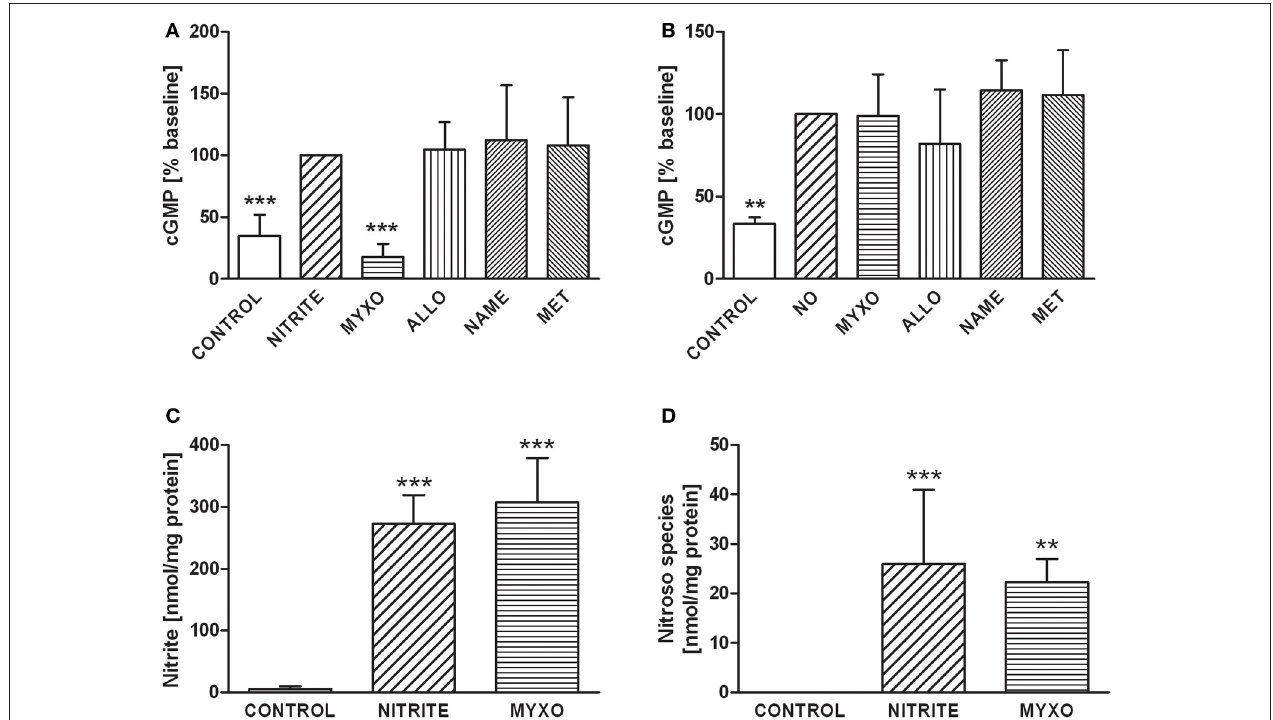
FIGURE 3 | (A) GMP levels in HL-1 incubated with 50 µ M nitrite under hypoxic conditions. cGMP production was completely inhibited